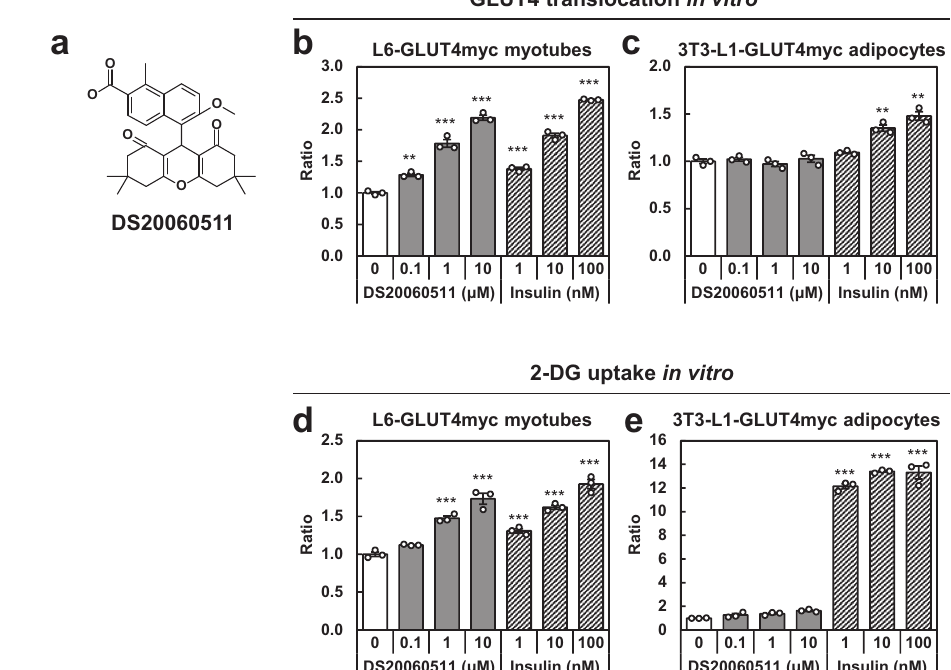
Fig. 1 A xanthene derivative, DS20060511, induced skeletal muscle-speci fi c GLUT4 translocation. a Chemical structure of DS20060511. b , c Concentration-dependent induction of GLUT4 translocation by DS20060511 and insulin in L6-GLUT4myc myotubes ( b ) and 3T3-L1-GLUT4myc adipocytes ( c ). d , e 2-DG uptake evaluated in L6-GLUT4myc myotubes ( d ) and 3T3-L1-GLUT4myc adipocytes ( e ). Values shown are means ± SEM, n = 3. ** P < 0.01, *** P < 0.001 vs. control by one-way ANOVA followed by Dunnett ’ s